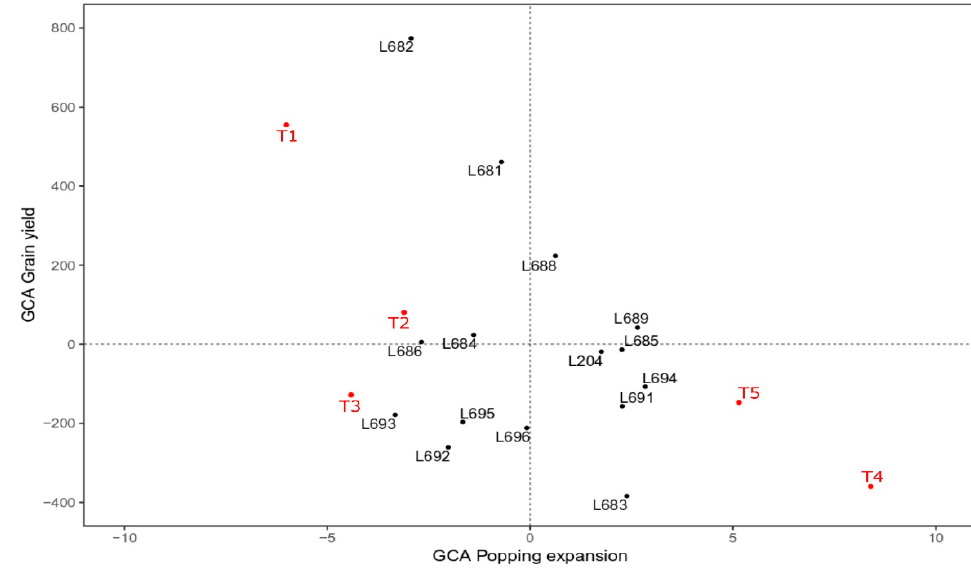
Figure 1. Scatter plot of estimates of general combining ability (GCA) effects associated with S 7 progenies tested—black dots (Group I)—and testers—red dots (Group II)—for grain yield and expandability traits. The T terms refer to the testers, these being T1 = PARA 172; T2 = L270; T3 = L651; T4 = P1; and T5 = L70. Table 3. Estimates of the effects of general combining ability (ˆgi) associated with S 7 progenies (Group I) and testers (Group II) for agronomic traits and associated with P. polysora , B. maydis, and E. turcicum